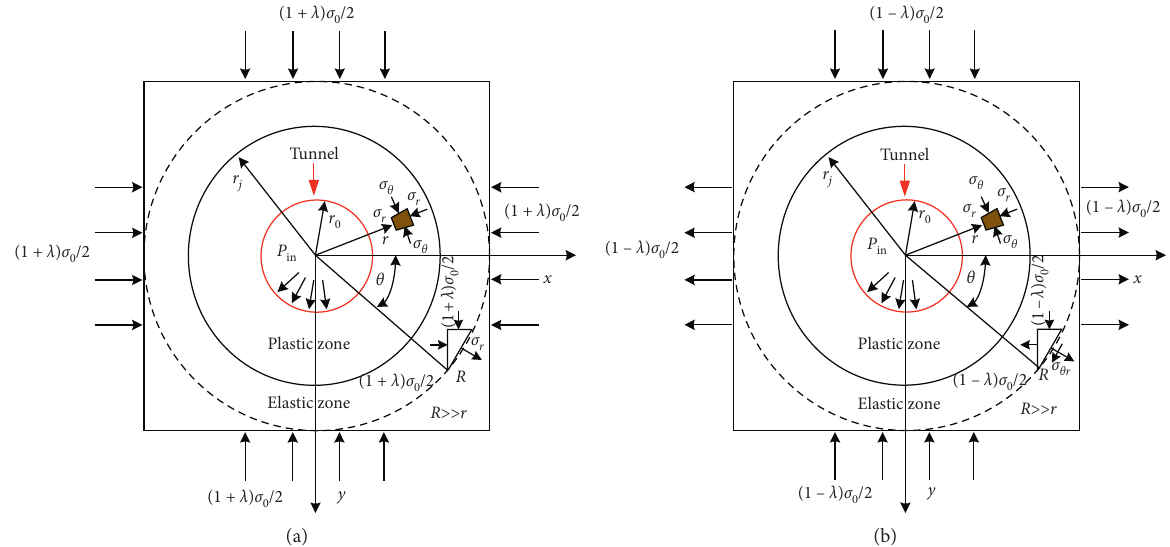
Figure 2: Equivalent mechanical model of a deep circular opening. (a) Uniform compressive stress field. (b) The stress field with horizontal tensile stress and vertical compressive